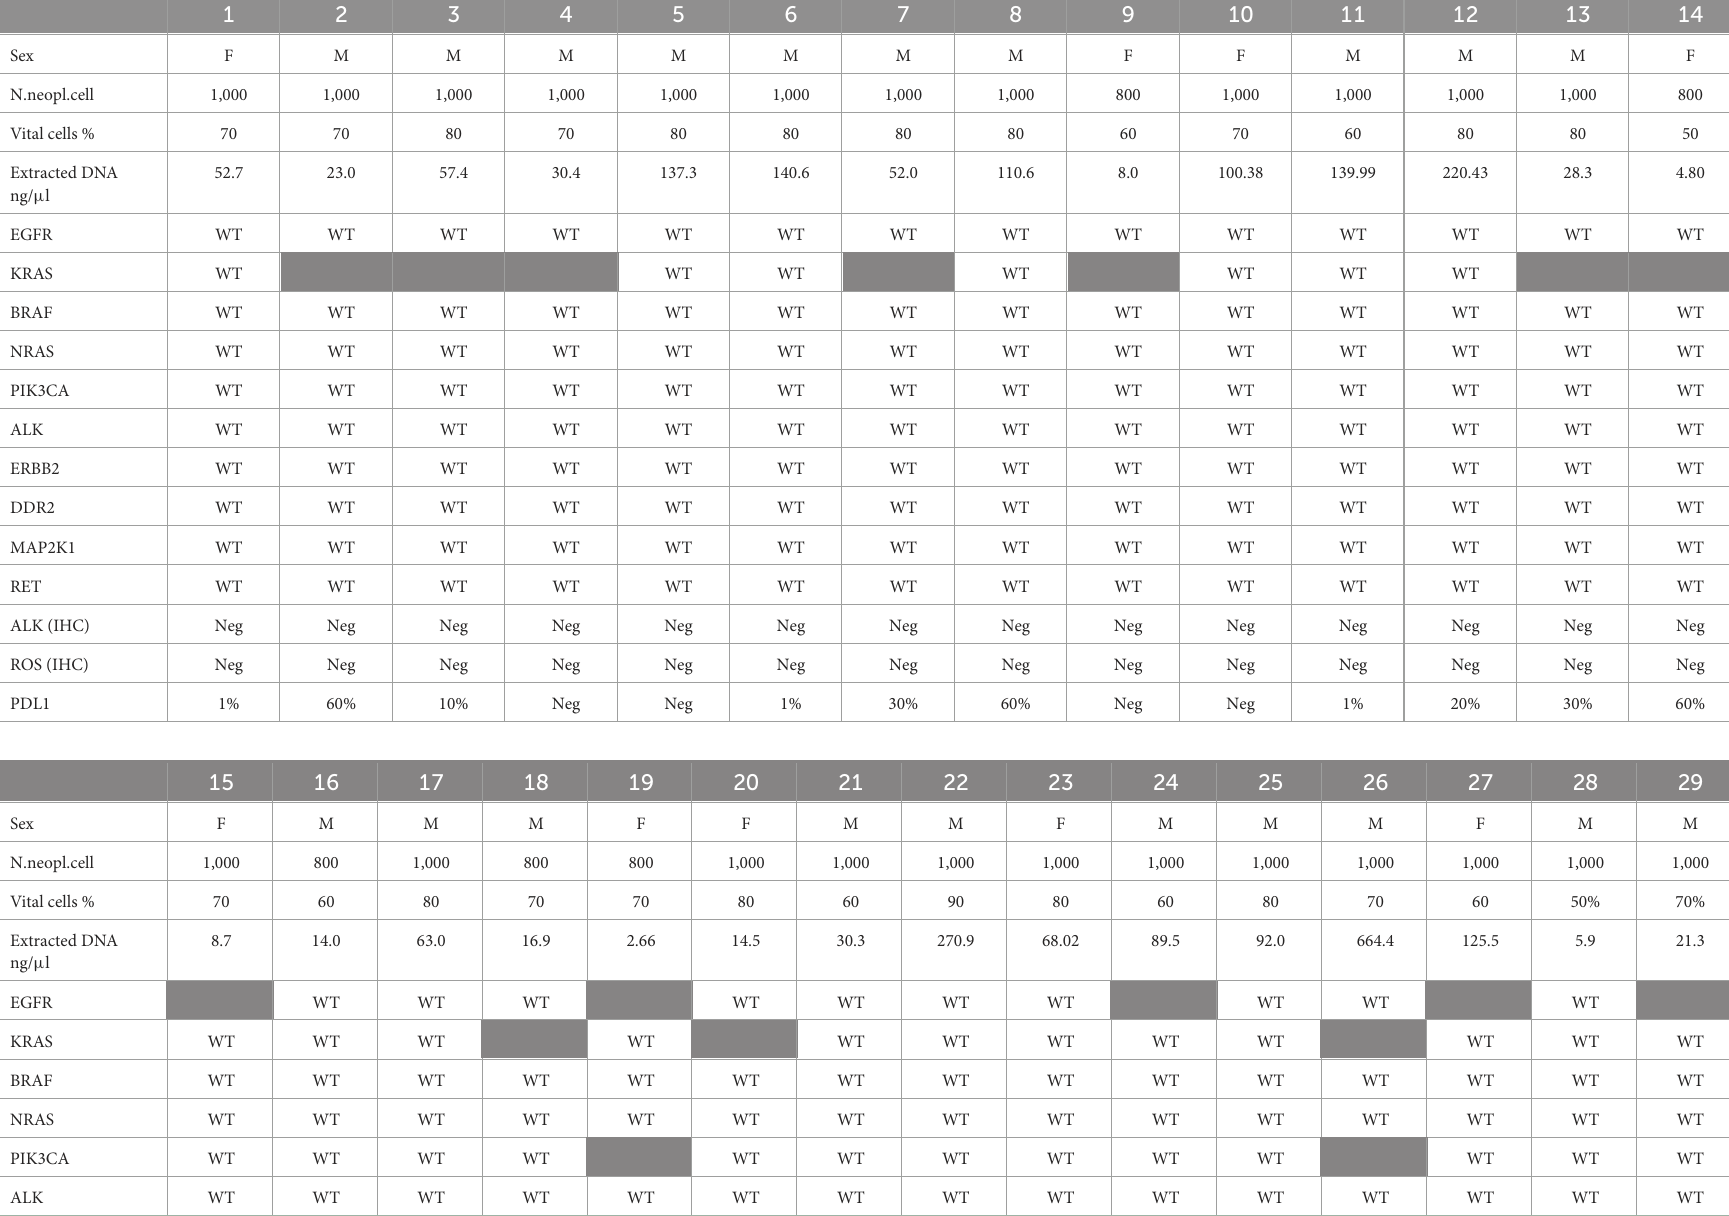
TABLE 3 Molecular characterization of 39 patients with primary lung adenocarcinoma obtained by TBNA